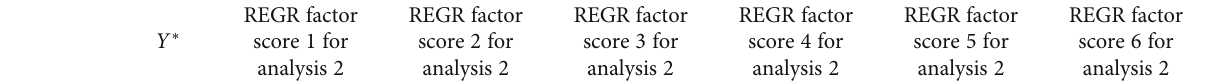
Table 3: Correlation coe ffi cients of factors (SPSS